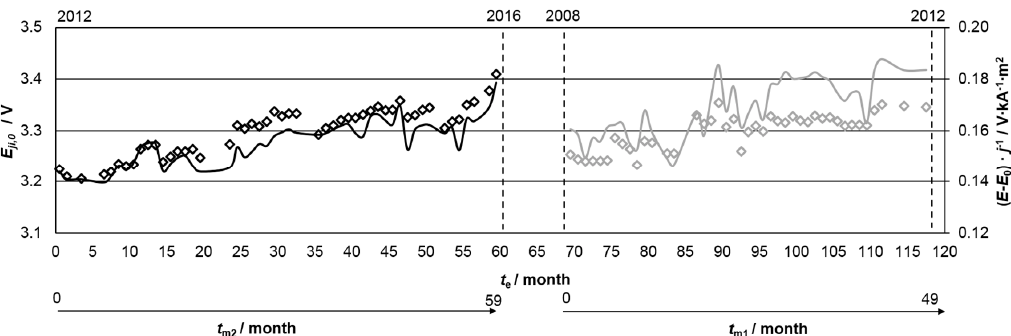
#m1) display E 0 values between 2.49 and 2.60 V and k -factor between 0.14 and 0.19 V·kA − 1 ·m 2 - cf. Figure 3. After their replacement (corresponded to #e2 and #m2 period), E 0 values are between 2.46 and 2.56 V and k -factor between 0.13 and 0.18 V·kA − 1 ·m 2 - cf. Figure 3. These results are within the reported normal range of k -factor. In this period, the k-factor values are smaller, which indicates a Figure 3. The monthly E 0 ( ) and k -factor ( (cid:78) ) values obtained from the polarization curves analysis. Figure 3. The monthly E 0 ( ● ) and k -factor ( ▲ ) values obtained from the polarization curves analysis. smaller ohmic resistance related to the use of different type of membranes. Typically, E 0 takes a value between 2.20 and 2.60 V and k -factor between 0.05 and 0.15 V·kA − 1 ·m 2 , when the membrane surface area is equal to 1.5 m 2 , according to good operating principals for the chlor-alkali industry [22]. For a membrane area of 5.4 m 2 , E 0 should be between 2.40 and 2.80 V and the k -factor between 0.15 and 0.25 V·kA − 1 ·m 2 . For the investigated bipolar membrane electrolyser, electrodes display a surface area around 3 m 2 . The first sets of electrodes and membranes (#e1 and